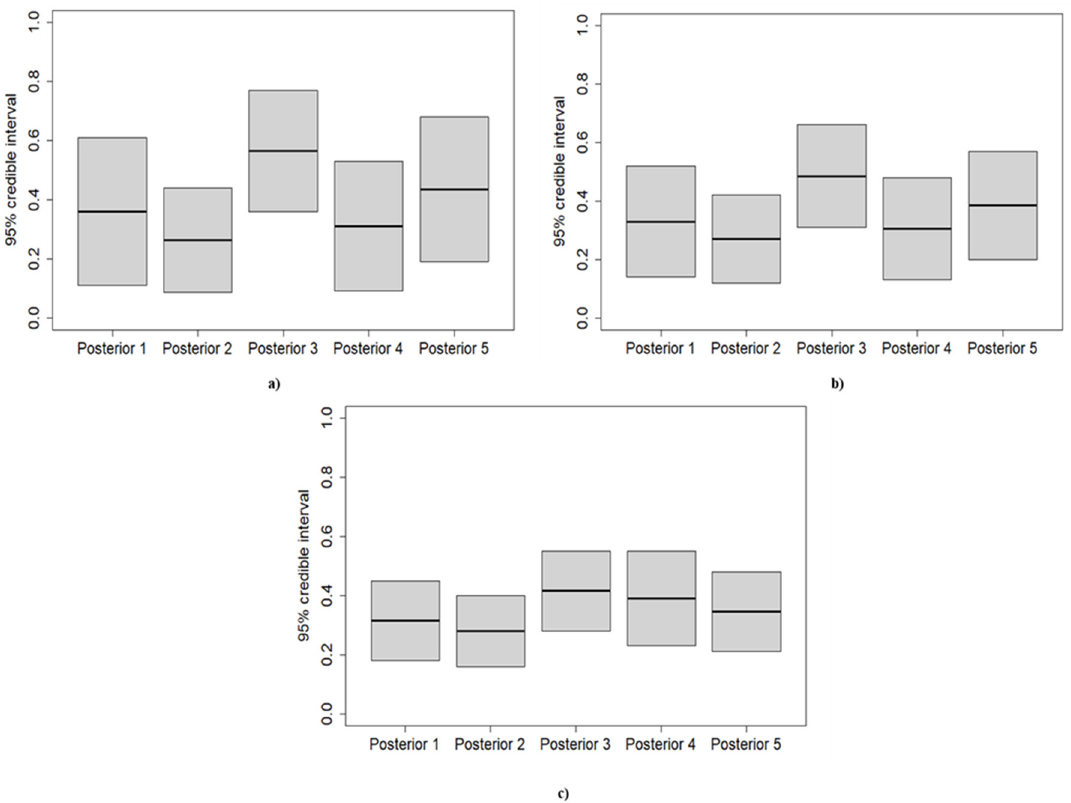
Figure 6. Uncertainties represented by the 95% credible interval of each posterior distribution for distinct priors. ( a – c ) arise from the first application (the sample with n = 10, k = 3), the second application (the sample with n = 20, k = 6), and the third application (the sample with n = 40, k = 12), respectively.